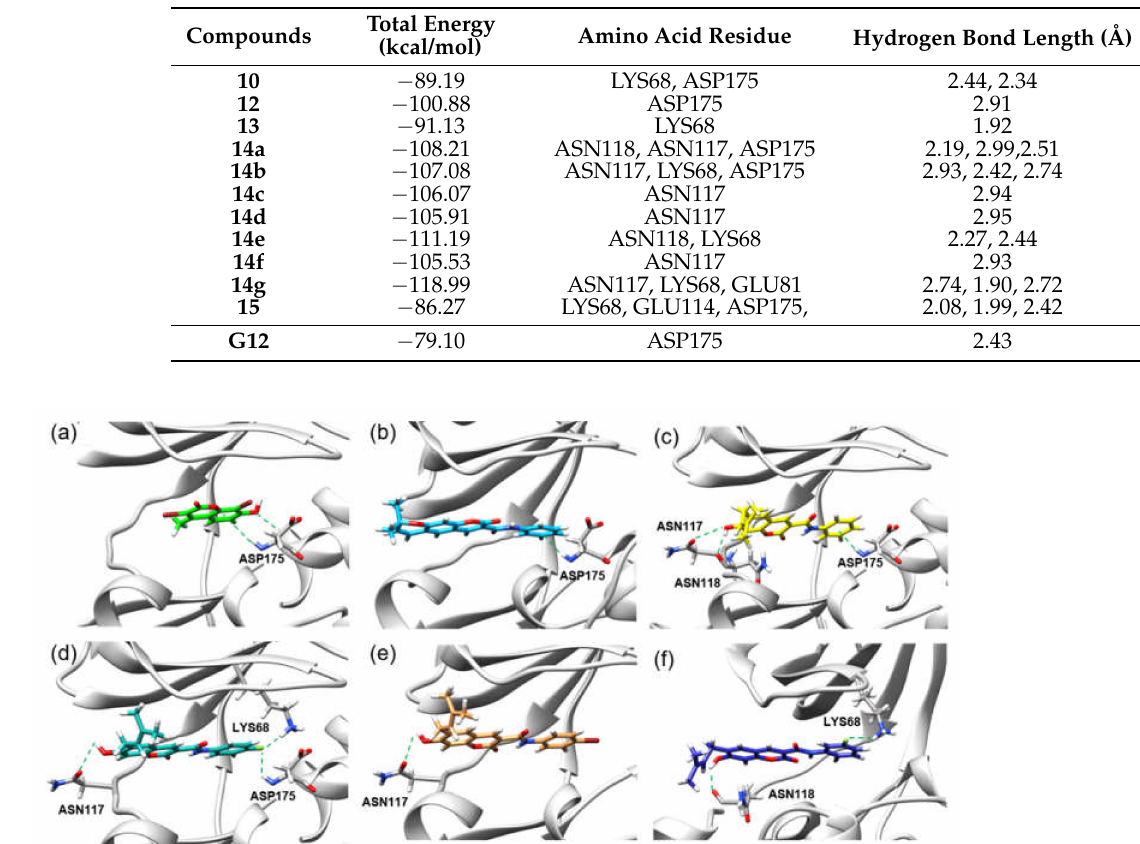
Table 3. Summary of binding energy, amino acid interactions, and hydrogen bond length of coumarin